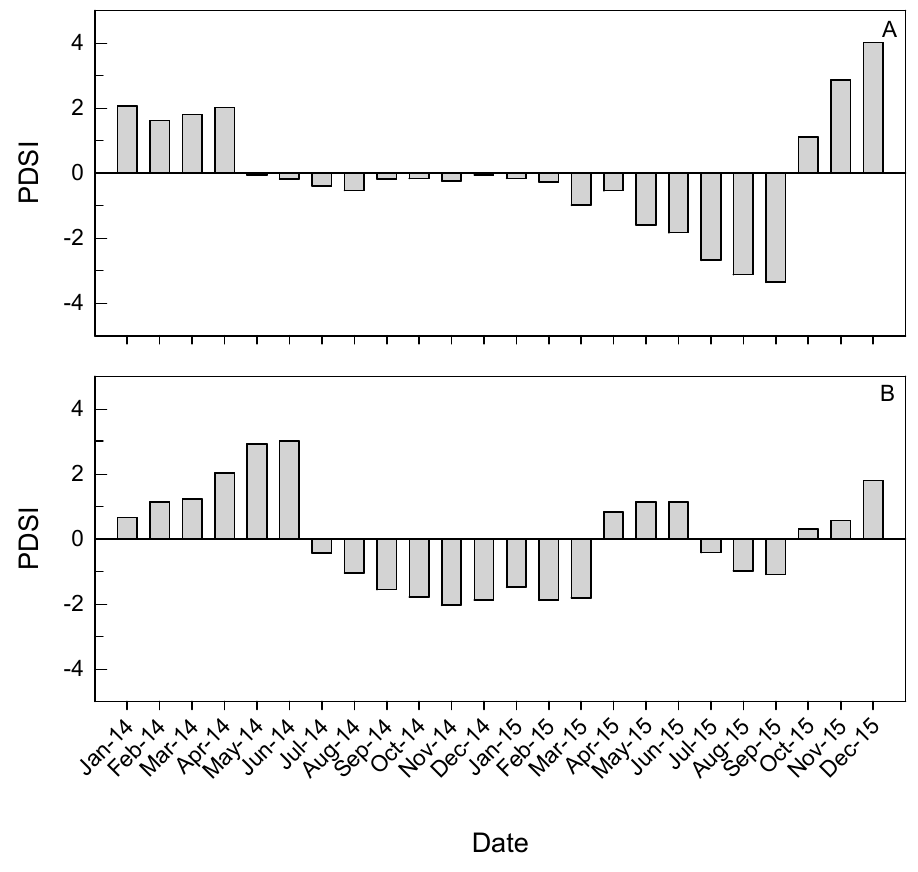
Figure 3. The Palmer Drought Severity Index (PDSI) at the North Carolina ( A ) and Mississippi ( B ) provenance test sites during the 2-year study.